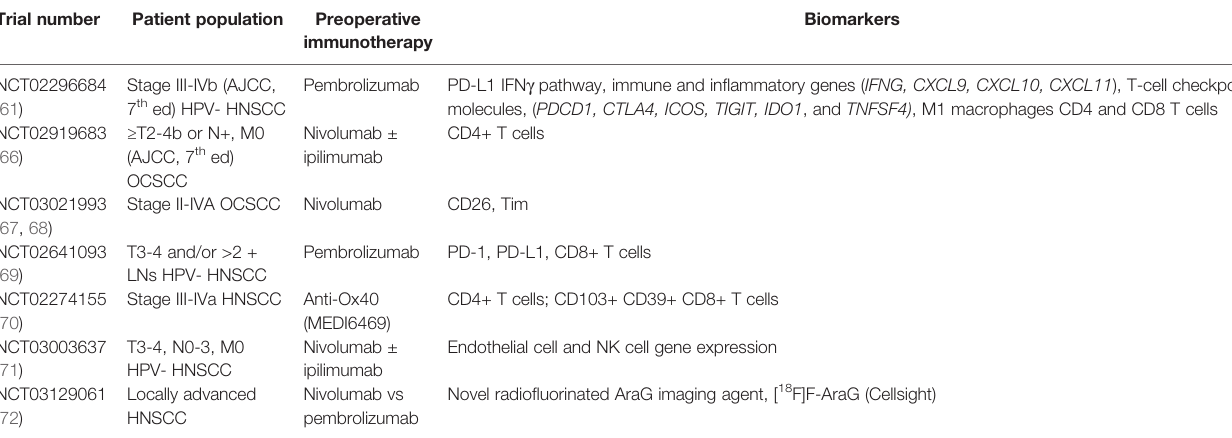
Trial number Patient